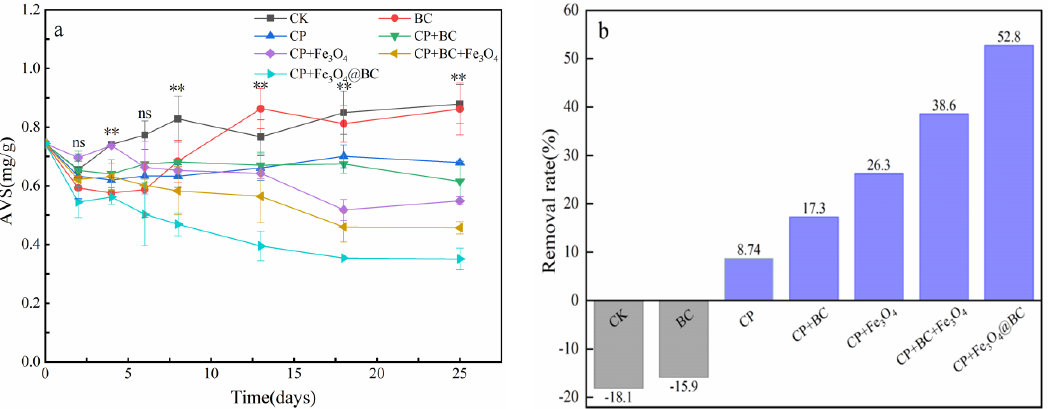
Figure 4. ( a ) The variation of AVS in the sediment during the experimental study; ( b ) The proportion of AVS in each group relative to the initial sediment on the 25th day; ** indicates a significant effect at the 0.01 probability level between the control and different treatments; ns indicates no significant effect at the 0.01 probability level between the control and different treatments.